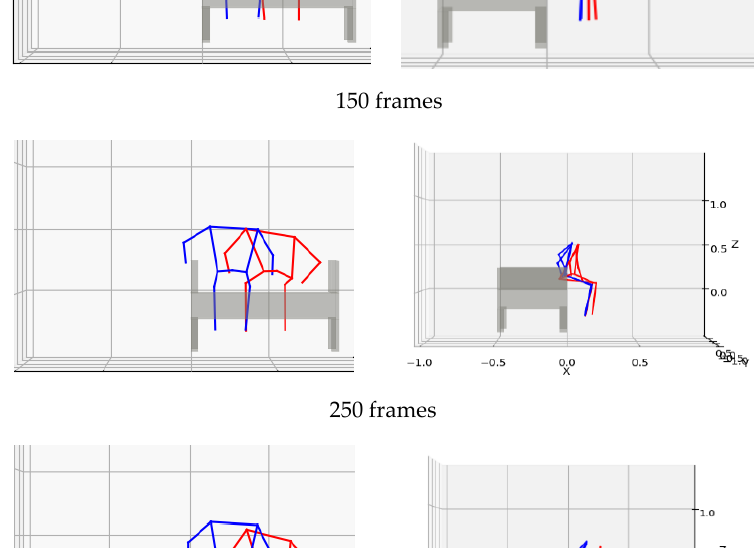
Figure 6. Average standing behavior in each cluster: red: cluster 1; blue: cluster 2.